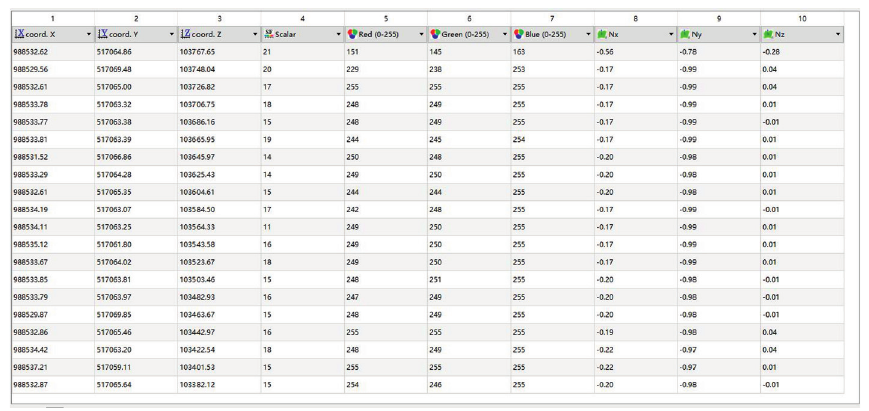
Figure 2: Raw LiDAR data for building